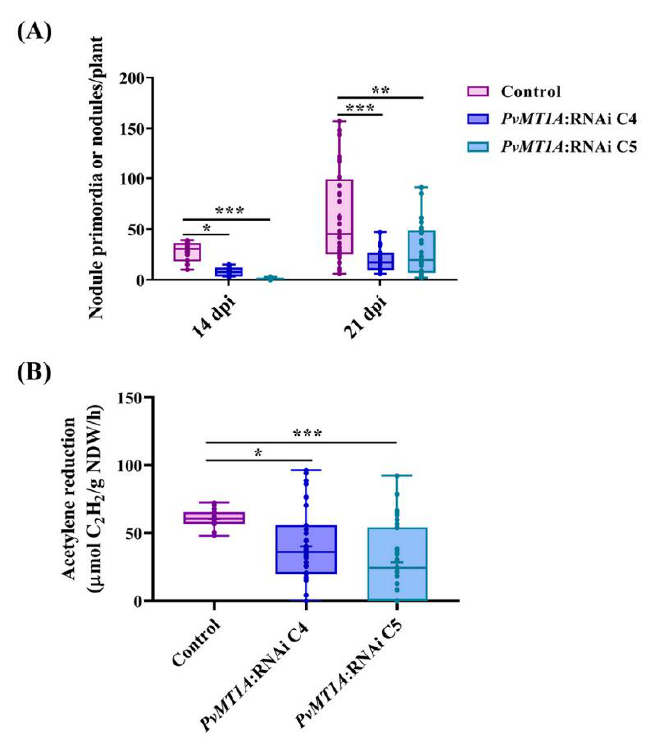
Figure 5. Measurement of nodulation capacity in control and PvMT1A -silenced transgenic roots. Total number of nodules in control, PvMT1A :RNAi C4, and PvMT1A :RNAi C5 hairy roots at 14 and 21 dpi ( A ). Nitrogenase activity in control, PvMT1A :RNAi C4, and PvMT1A :RNAi C5 transgenic roots inoculated with R. tropici at 21 dpi, as determined by an acetylene reduction assay ( B ). The top and bottom edges of the boxes delineate the first to third quartiles, the horizontal line within the box represents the median, and the whiskers represent the smallest and largest outlier in the data set ( n = 30). A non-parametric Kruskal – Wallis test followed by Dunn’s multiple comparisons test was performed to evaluate significant differences, * p ≤ 0.05, ** p ≤ 0.01, *** p ≤ 0.001.